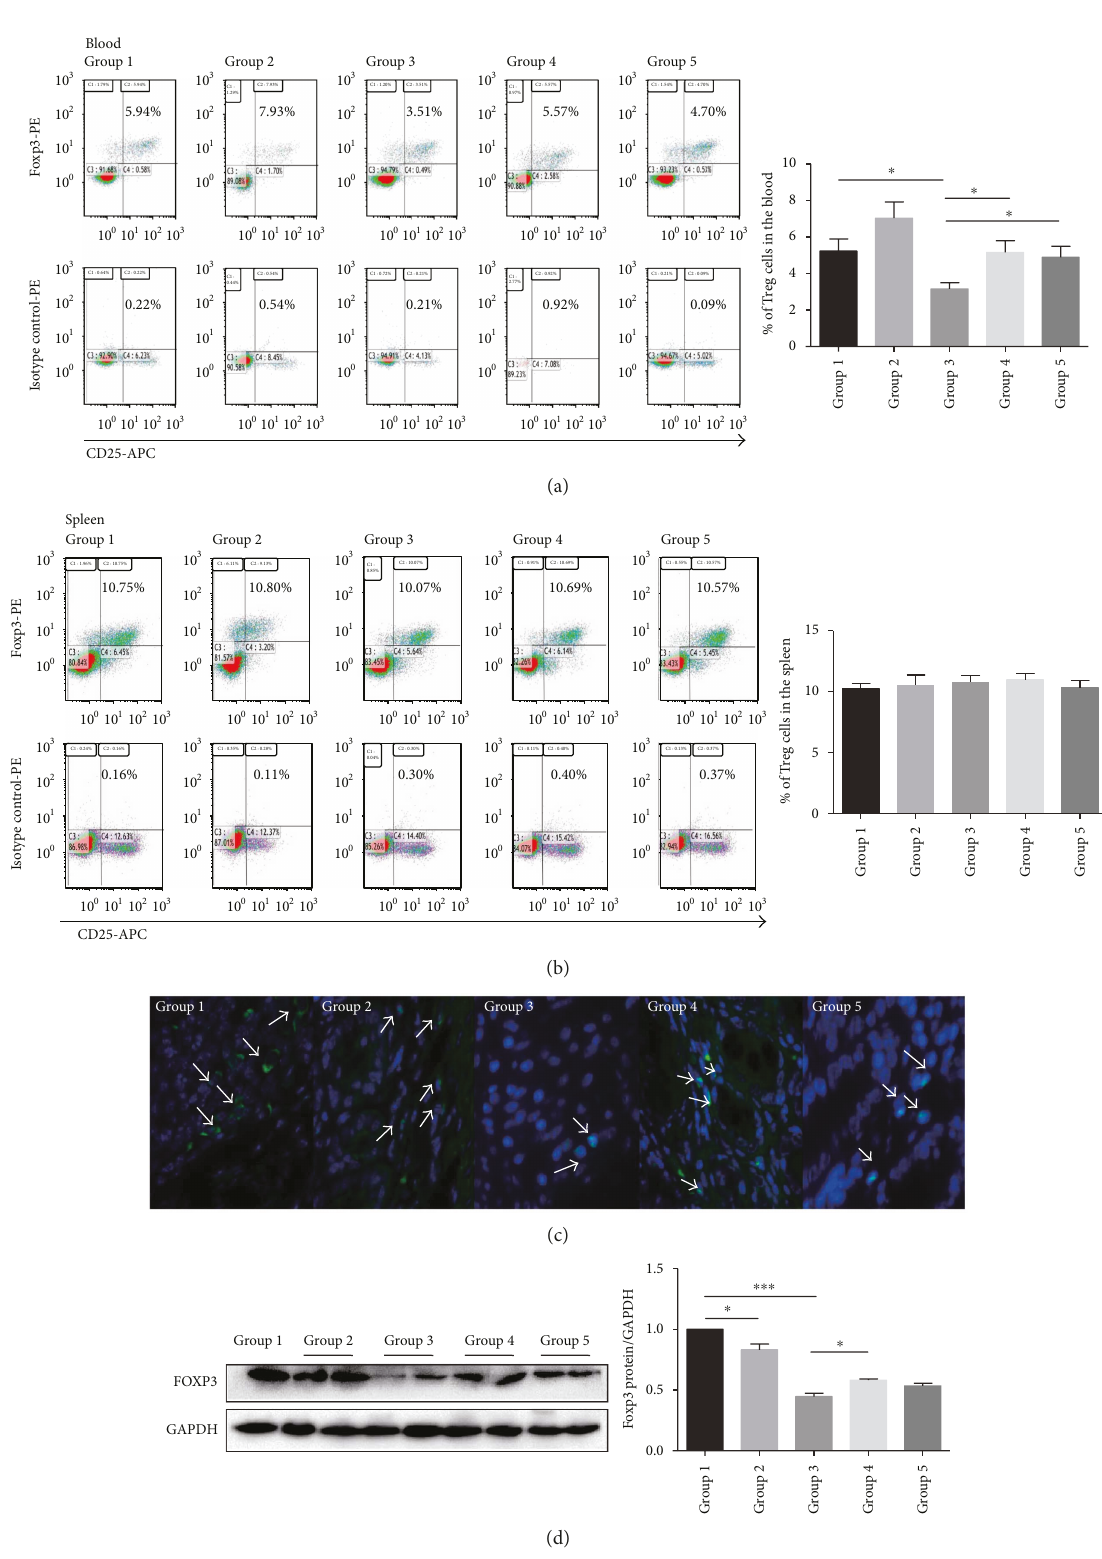
Figure 6: The proportion of total CD4 + CD25 + Foxp3 + Tregs cells in the peripheral blood and spleen. (a) The frequency of Treg cells in the blood ( n = 6 – 9/group) (b) and in the spleen ( n = 6 – 9/group). (c) The number of Foxp3 + cells in colonic tissue (the white arrows indicate Fox3 + cells). (d) Western blot analysis of mice colonic Foxp3 protein expression level in each group. Group 1 normal ( n = 3 ); group 2 Bi fi co ( n = 6 ); group 3 colitis ( n = 6 ); group 4 pretreated- Bi fi co -colitis ( n = 6 ); group 5 pretreated+ treated- Bi fi co -colitis ( n = 6 ). Data represent means ± SEM . ∗ P < 0 05 and ∗∗∗ P < 0 001